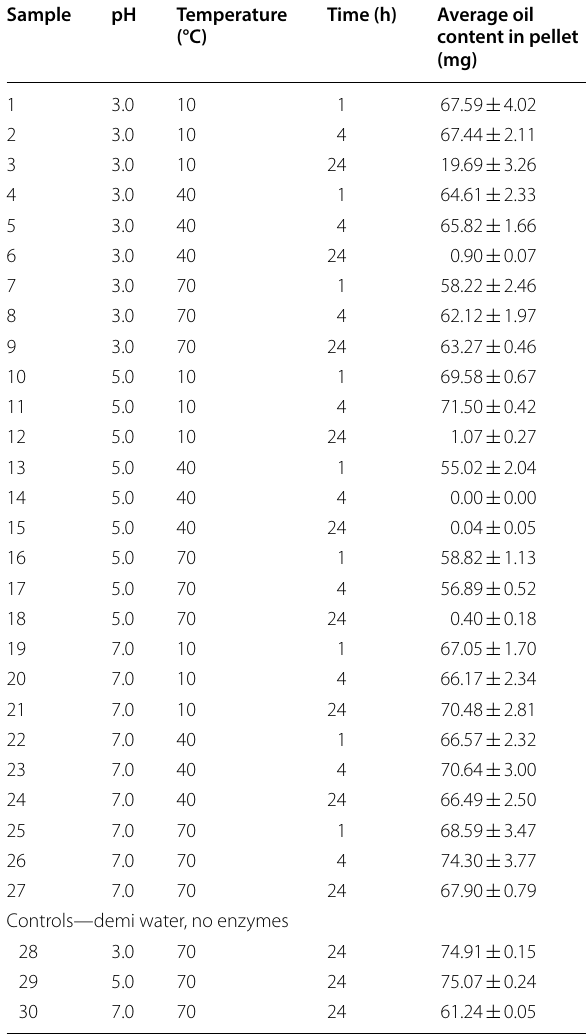
Table 3 Total oil content remaining in 30% (v/v) fat Schwanniomyces occidentalis pellet after using tailor-made enzymes in a variety of conditions in temperature, pH, and time